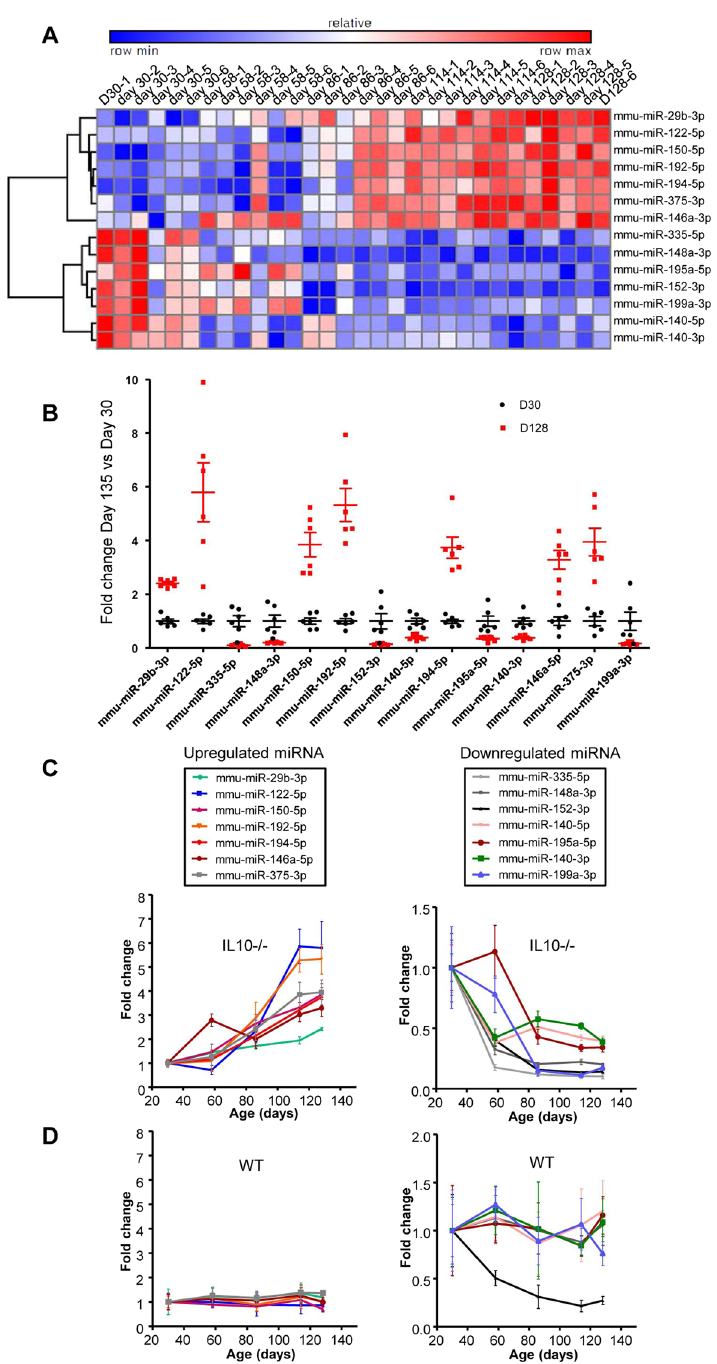
Figure 1. Serum miRNA profiles in a discovery cohort of IL10 − / − mice. Sera were collected from IL10 − / − mice at age 30, 58, 86, 114 and 128-days and subjected to miRNA profiling. ( A ) Hierarchical clustering showing the relative expression levels of the 14 deregulated miRNAs in each sample. ( B ) Expression profiles of miRNAs in colitic mice (D128) compared to the same mice before they develop colitis (D30). The average expression of each miRNA in non-colitic mice was set to 1. ( C ) Age-dependent representation of the expression profiles of the 14 deregulated miRNAs in the sera of IL10 − / − mice. Seven were increased (left panel), and seven were decreased (right panel). ( D ) The expression levels of these differentially expressed miRNAs were analyzed in sera from WT mice. Data are given as the means + / − S.E.M. (n =